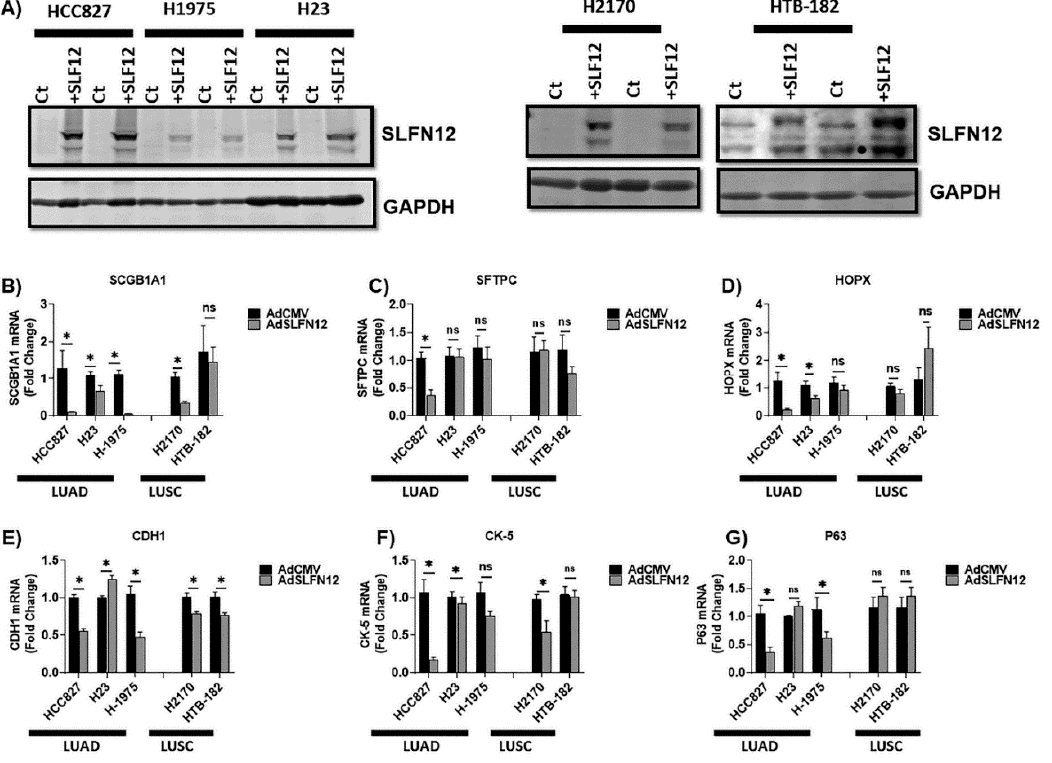
Figure 2. SLFN12 modulates mRNA levels of differentiation markers in lung cancer cells. ( A ) Representative Western blot images confirm successful SLFN12 overexpression in lung adenocarcinoma cells (HCC827, H1975, and H23 cells) and in lung squamous cell carcinoma cells (H2170 and HTB-182 cells). Glyceraldehyde 3-phosphate dehydrogenase (GAPDH) was used as a housekeeping protein control. (ct = background adenovirus AdCMV, SLF12 = AdSLFN12). mRNA analysis by Primer-probe qPCR, 72 hours after AdSLFN12 or AdCMV treatment for the following: ( B ) SCGB1A1, ( C ) SFTPC, ( D ) HOPX, ( E ) CDH1, ( F ) CK-5, and ( G ) P63 in HCC827, H23, H1975, H2170, and HTB-182 cells ( n = 3–12) (Hypoxanthine-guanine phosphoribosyltransferase (HPRT) was used as a reference gene, data normalized to AdCMV group, ns = non-significant, * p < 0.05). All data are represented as mean ± SEM. Detailed information about western blot can be found at Figure S1.